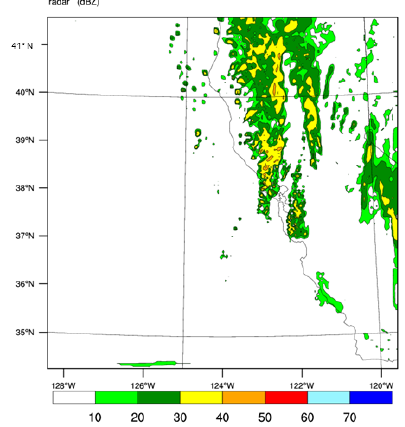
Figure 10. WRF-simulated radar product valid at 18Z on 30 October 2016.